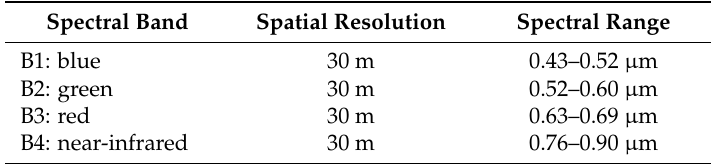
Table 1. The main parameters of the wide-band and multi-spectral camera (CCD) imagery of Chinese HuanJing satellite (HJ-CCD).